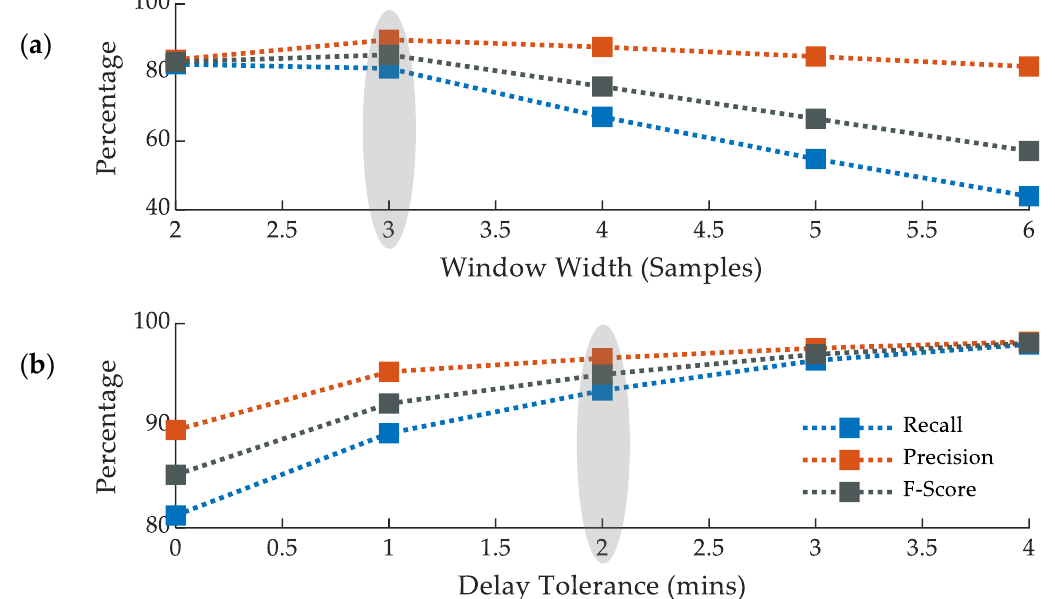
Figure 3. Event detection performance results ( a ) window width, ( b ) delay tolerance (shaded region represents the best results).